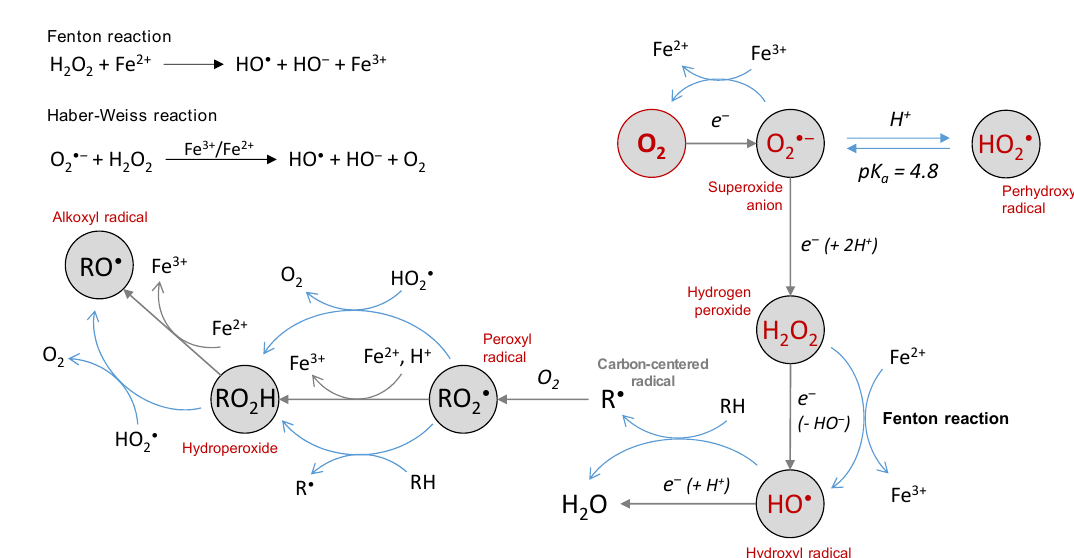
Figure 1. The chemical basis of Reactive Oxygen Species (ROS) generation—primary radical and molecular species are produced by incomplete reduction of molecular oxygen and can further react with an organic substrate to generate substrate-derived ROS. Metal ions are engaged in electron transfer (through metalloenzymes in vivo), but also involved in both Fenton and Haber-Weiss reactions, and in the reduction of hydroperoxide into alkoxyl radical.